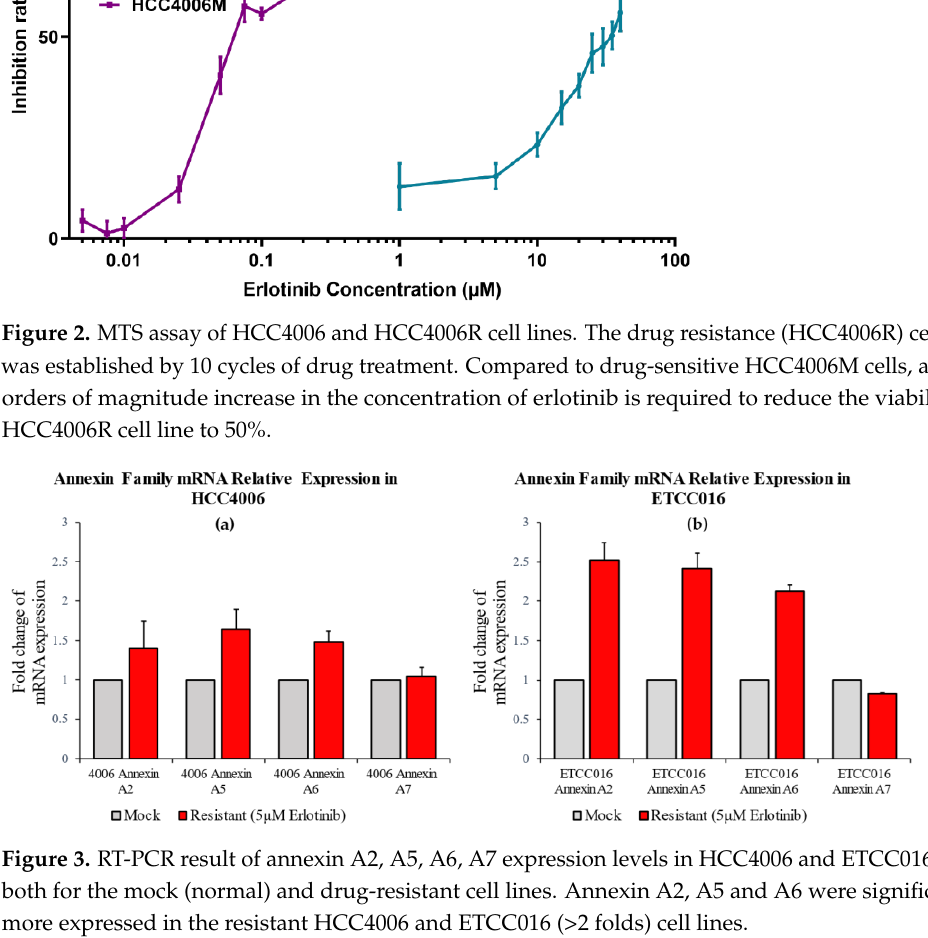
Figure 3. RT-PCR result of annexin A2, A5, A6, A7 expression levels in HCC4006 and ETCC016 cells, both for the mock (normal) and drug-resistant cell lines. Annexin A2, A5 and A6 were significantly more expressed in the resistant HCC4006 and ETCC016 (>2 folds) cell